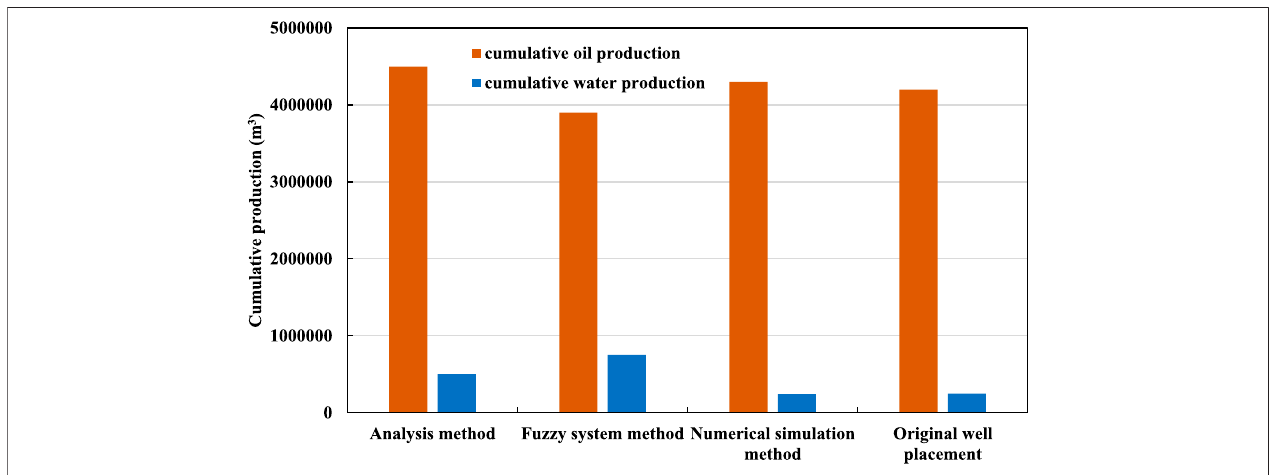
FIGURE 7 | Comparison of well location results between the three methods and the original well plan.